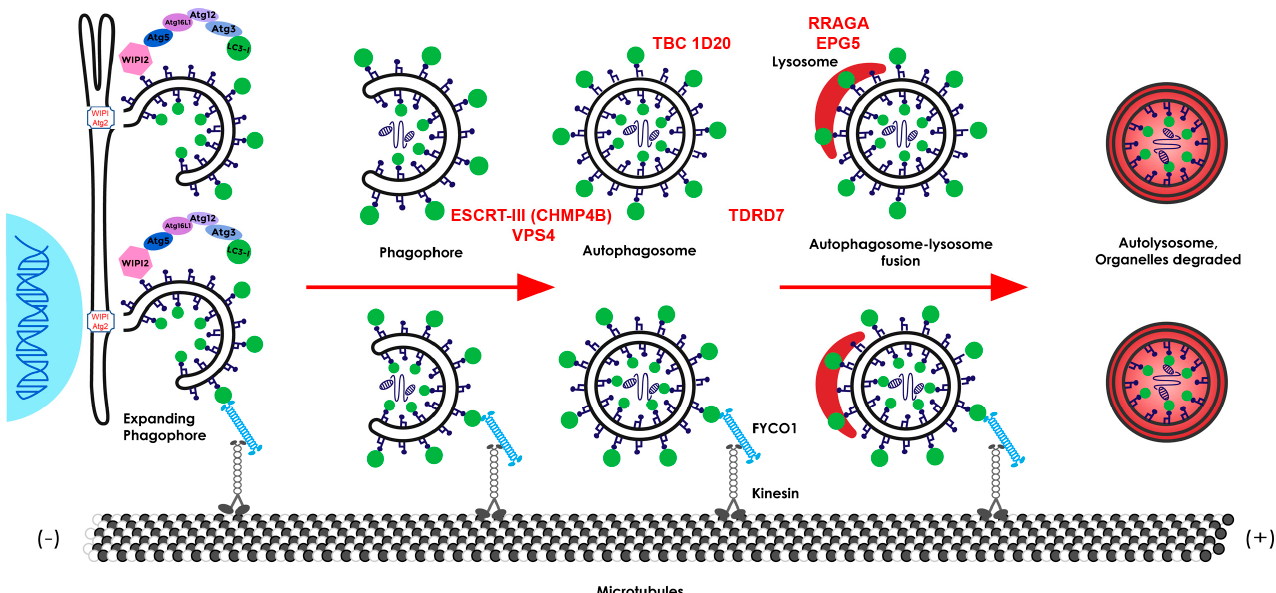
Figure 6. Overview of autophagy, with the components implicated in human cataractogenesis shown in red above the steps in which they are active (shown as red arrows). FYCO1 is shown below, binding to LC3 and PtdIns(3)P, which are active through the formation of the autolysosome.